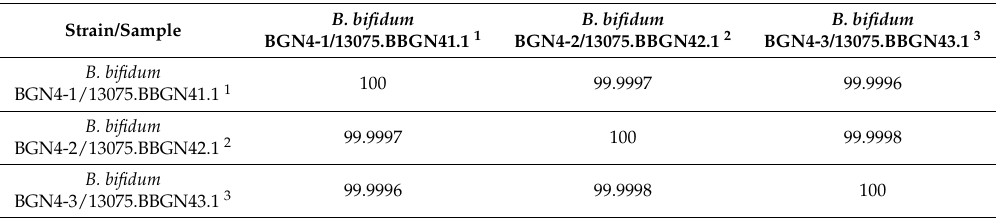
Table 5. OrthANI value